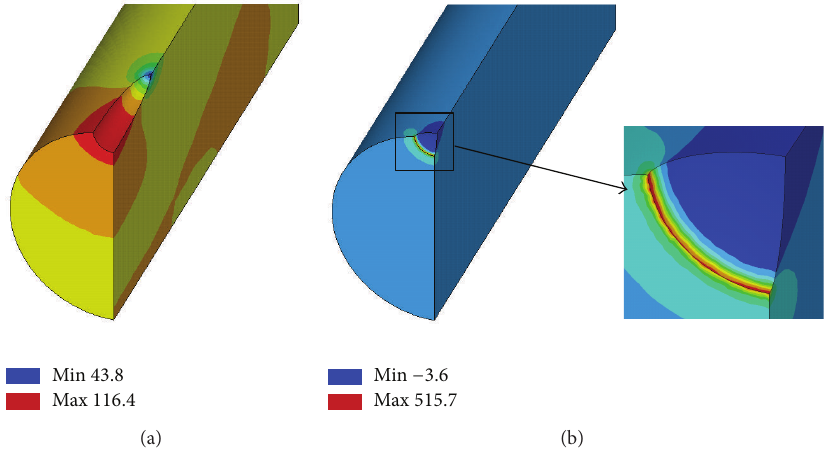
Figure 5: Stress distributions near the pit with various aspect ratios: (a) 𝑎/𝑏 = 0.2 , (b) 𝑎/𝑏 = 3.33